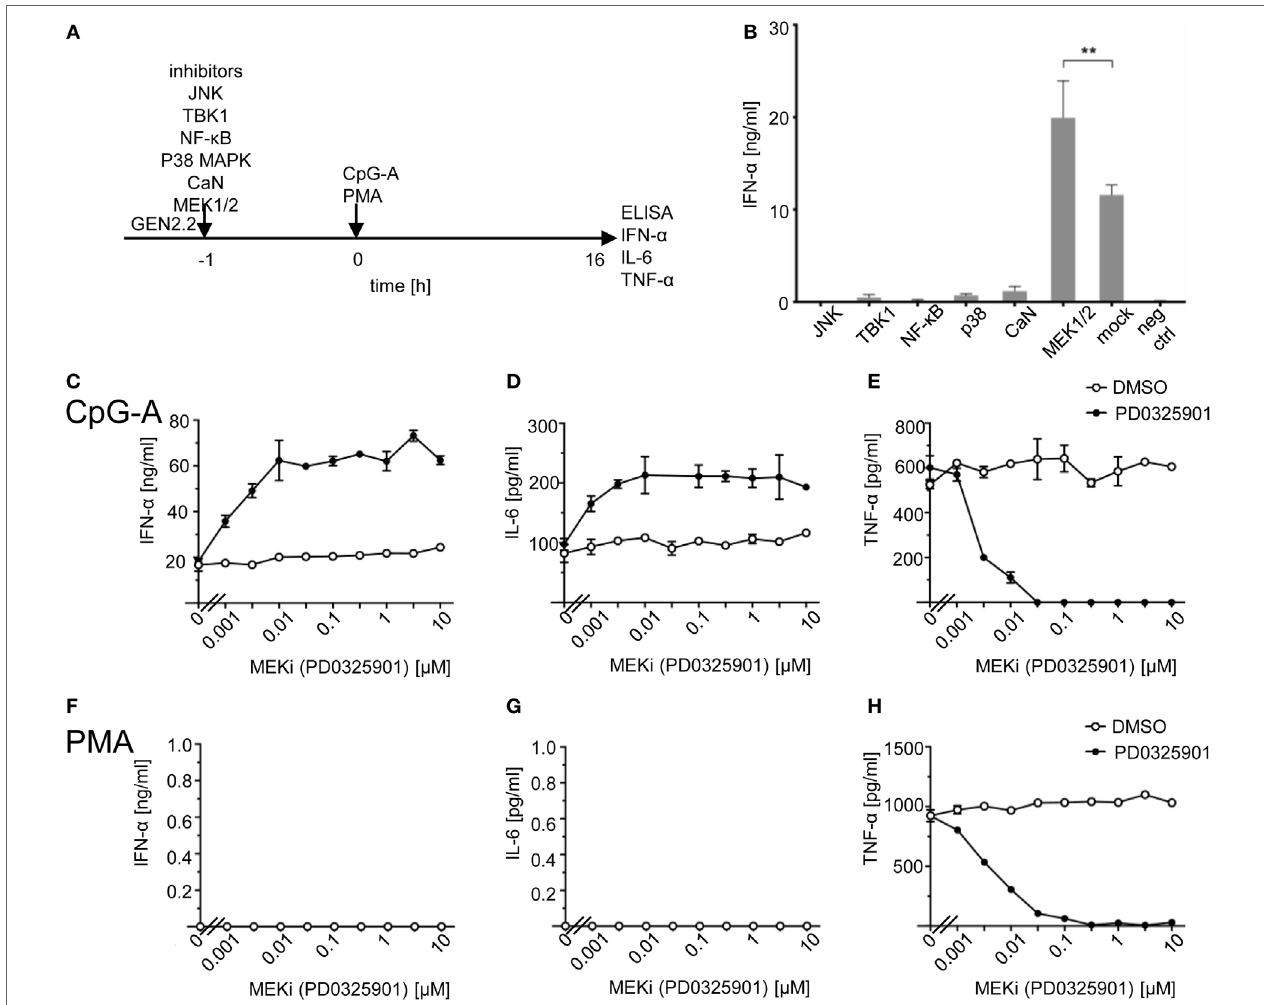
FigUre 1 | Effect of MEK1/2 inhibitor PD0325901 on cytokine production in CpG-A and phorbol myristoyl acetate (PMA)-stimulated GEN2.2 cells. (a) Experimental outline. GEN2.2 cells separated from MS-5 feeder cells were exposed or not to inhibitors of Jun N-terminal kinase (JNK), TANK binding kinase 1 (TBK1), NF- ĸ B, p38 MAPK, calcineurin, or MEK1/2 for 1 h and then stimulated with CpG-A at 4 µg/ml. The concentration of IFN- α , IL-6, and tumor necrosis factor α (TNF- α ) in the cell-free supernatant was determined by ELISA after a 16 h treatment. (B) The production of IFN- α by GEN2.2 cells stimulated with CpG-A in the presence of JNK (SP600125, 10 µM), TBK1 (BX795, 1 µM), NF- ĸ B (Bay11-7082, 1 µM), p38 MAPK (SB253080, 1 µM), calcineurin (FK506, 0.1 µM), or MEK1/2 (PD0325901, 1 µM) inhibitors. The PD0325901 concentration-dependent production of IFN- α ( c,F) , IL-6 (D,g) , and TNF- α (e,h) in CpG-A-induced (c–e) or PMA-induced (F–h) GEN2.2 cells. The data show mean and SEM of two independent experiments in biological triplicates (B–h) . **, p < 0.01; two-tailed Mann–Whitney